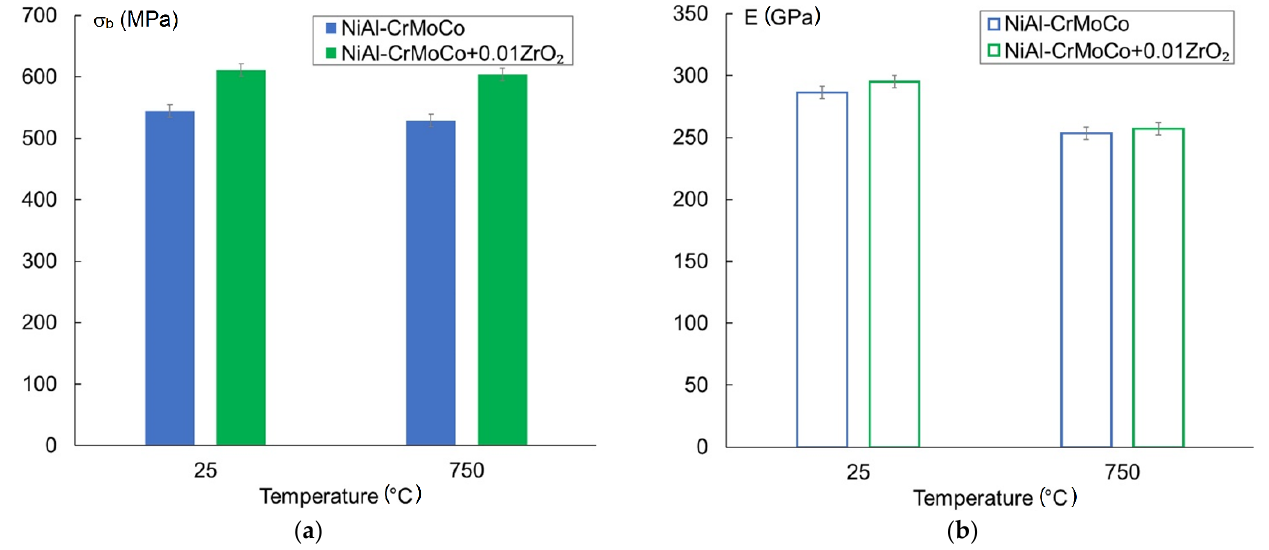
Figure 16. Bending strength ( a ) and Young’s modulus ( b ) of composites at test temperatures of 25 °C and 750 °C.